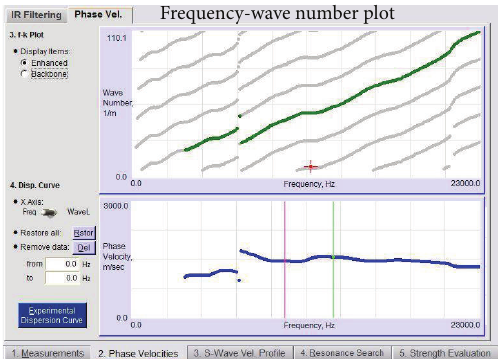
Figure 8: Inversion analysis (determination of the thickness of each pavement layer based on the shear wave velocity ( 𝑆 wave)).